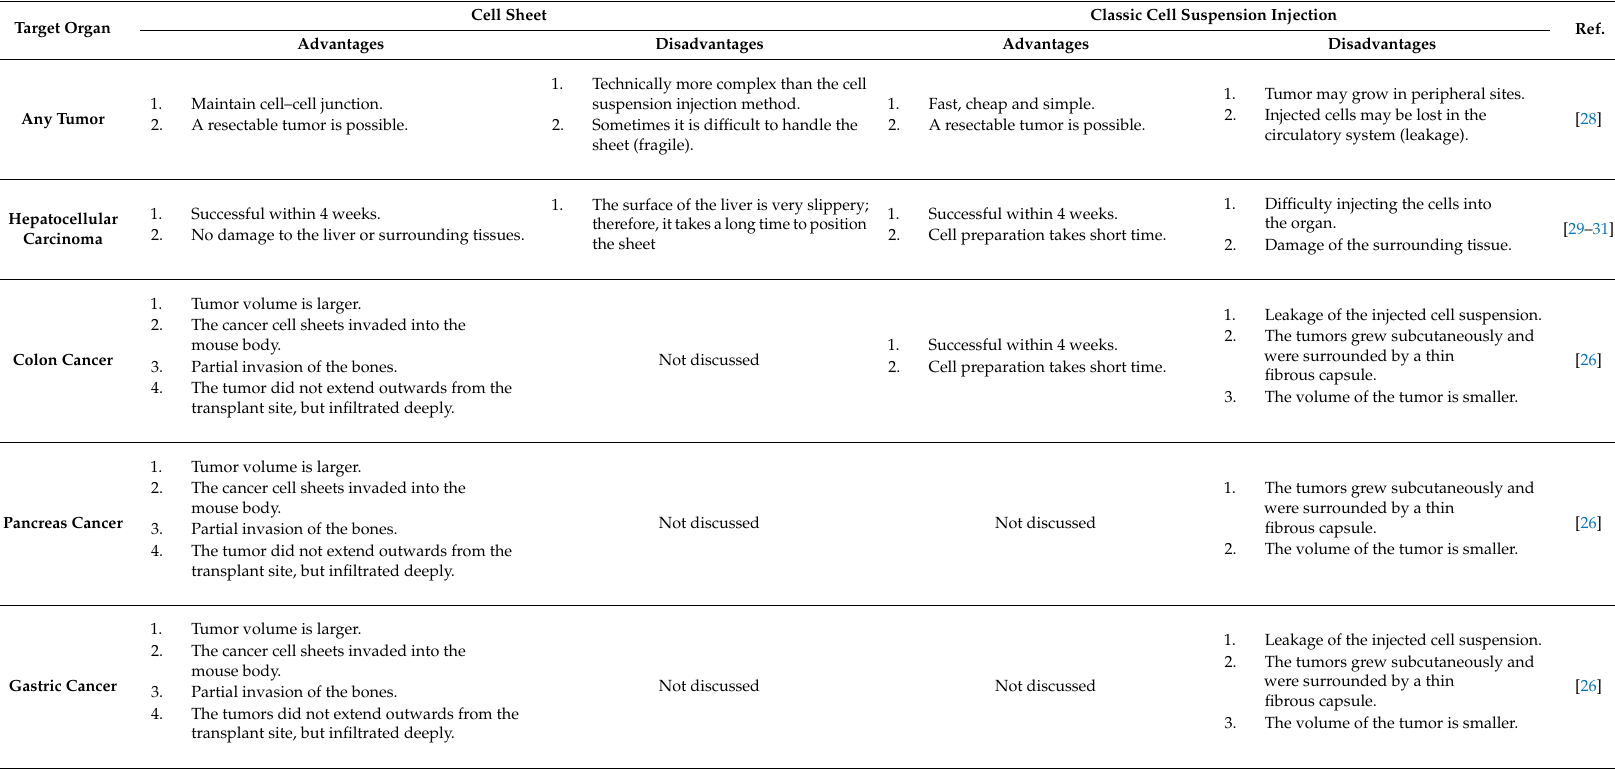
Table 2. Cell sheet technique vs classic cell suspension injection method in modeling solid tumors in